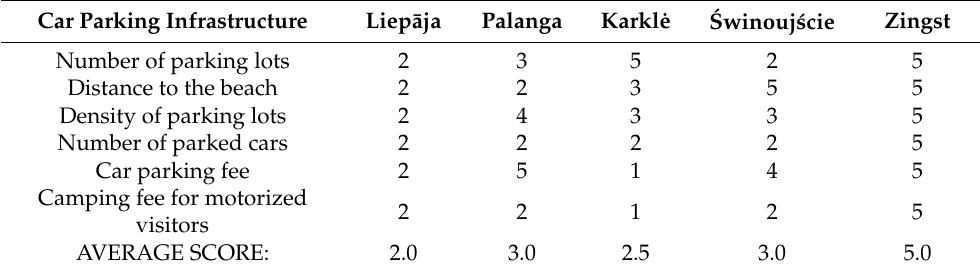
Table 4. Main aspects of the beach accessibility infrastructure in the studied South Baltic seaside resorts (scores from 1—poor to